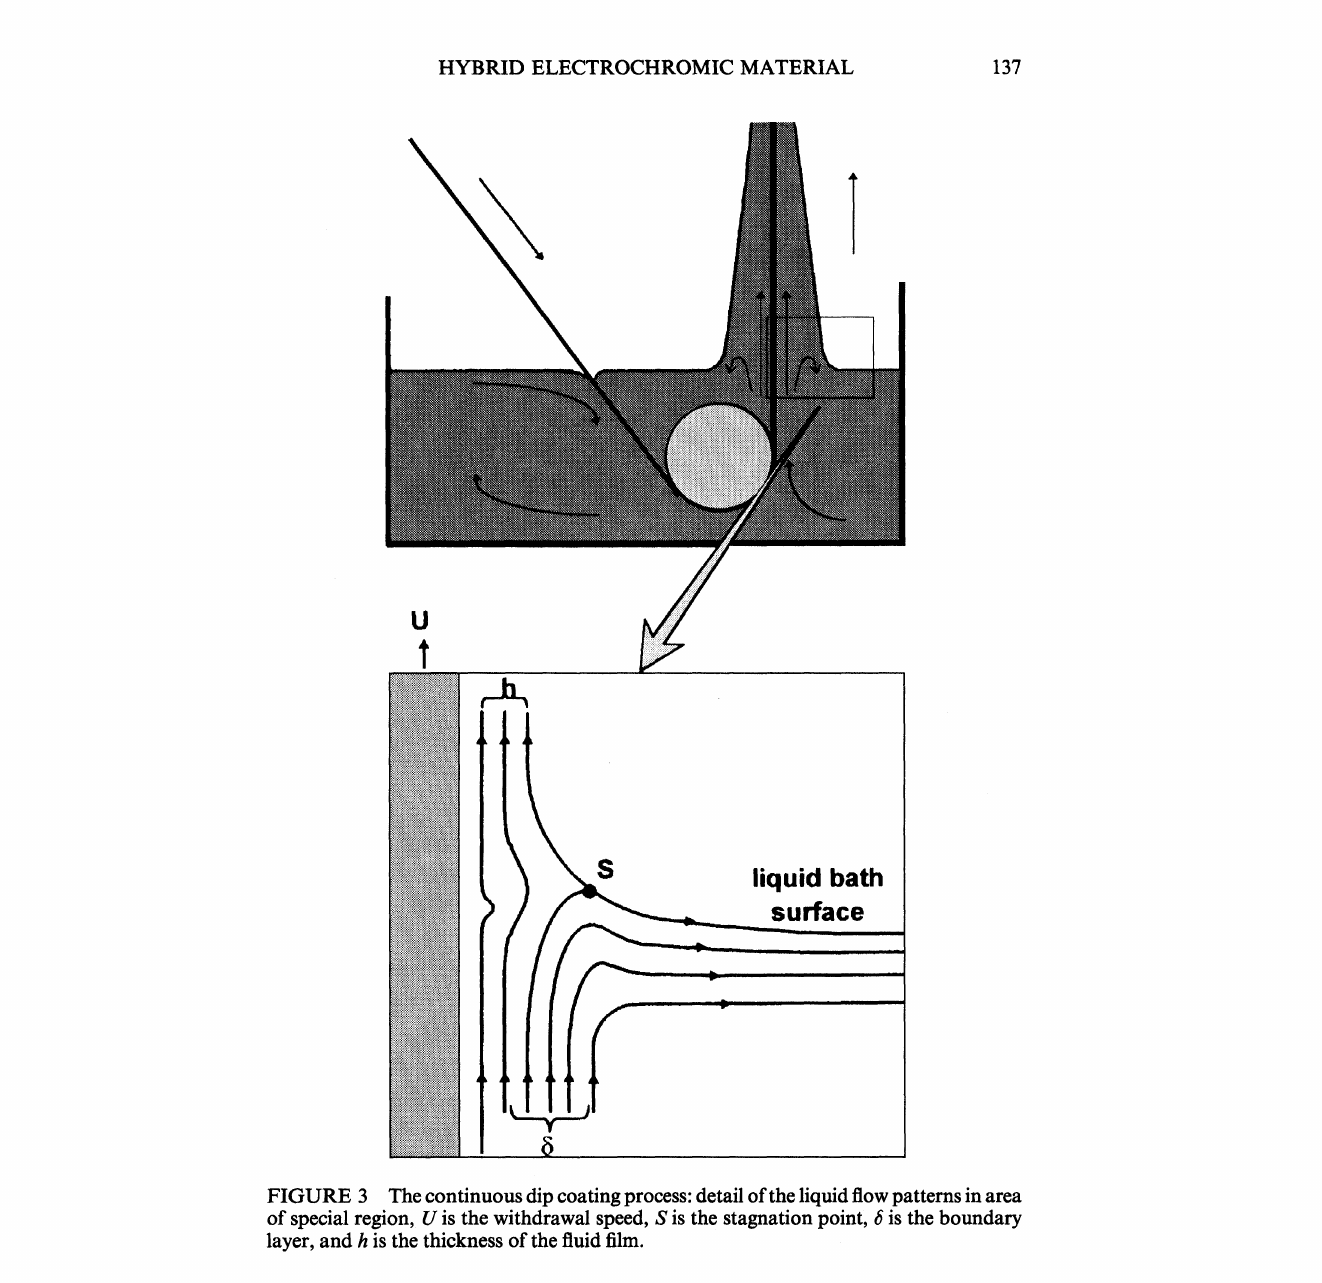
FIGURE 3 The continuous dip coating process: detail ofthe liquid flow patterns in area of special region, U is the withdrawal speed, S is the stagnation point, 6 is the boundary layer, and h is the thickness of the fluid